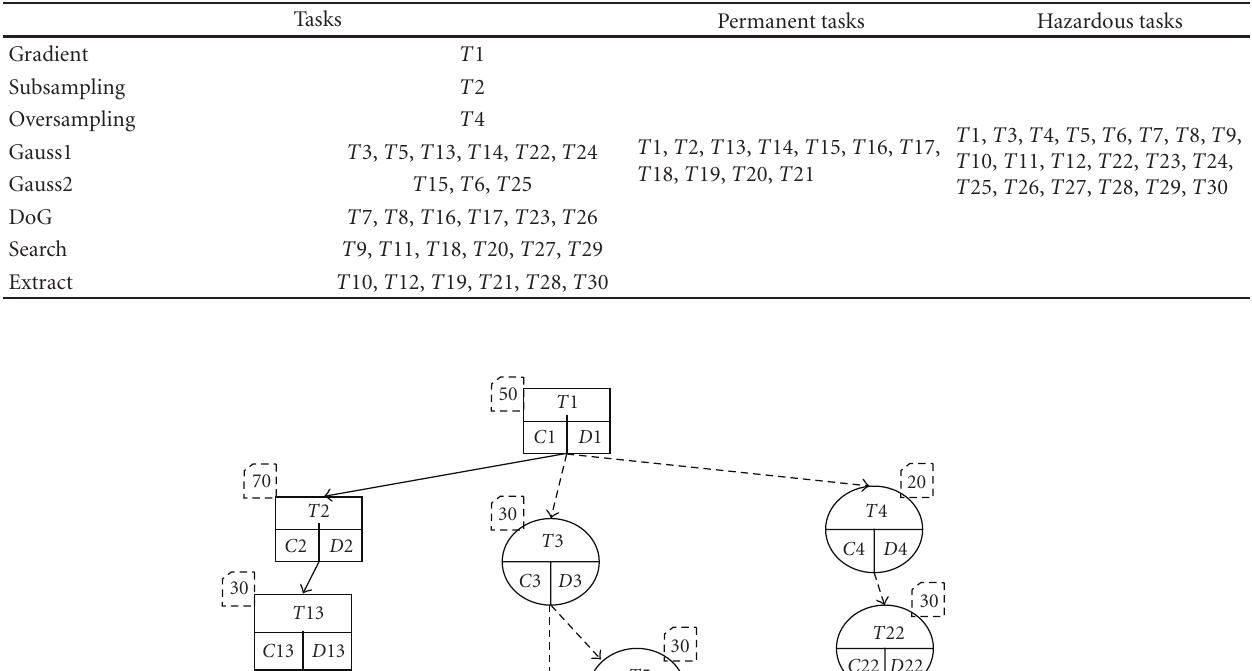
Table 1: Identification of the robotic application tasks.